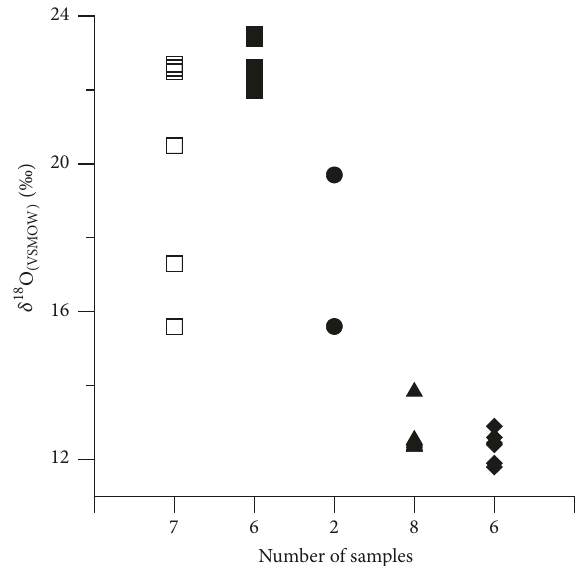
Figure4:Comparisonsamong 𝛿 18 O ( valuesofplantashglass VSMOW ) samples [open symbols: Thessaloniki, various sites ( ◻ )] and those already reported in the literature [full symbols: glass from Nimrud and Aphrodisias ( ◼ ) [2]; glass from Ra’s al-Hadd ( e ) and Levantine soda ash glass ( X ) [12]; Medieval soda ash glass from Italy ( 󳵳 ) [3]]. Number of analysed samples is also